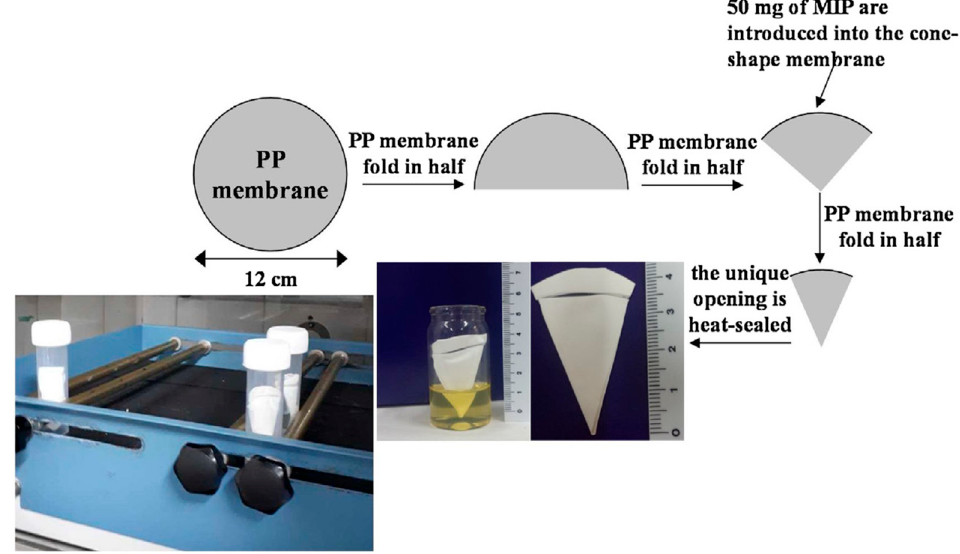
Figure 10. Schematic of the preparation of the MIP- μ -SPE device. Reprinted from [44], with permis- sion from Elsevier, 2018.